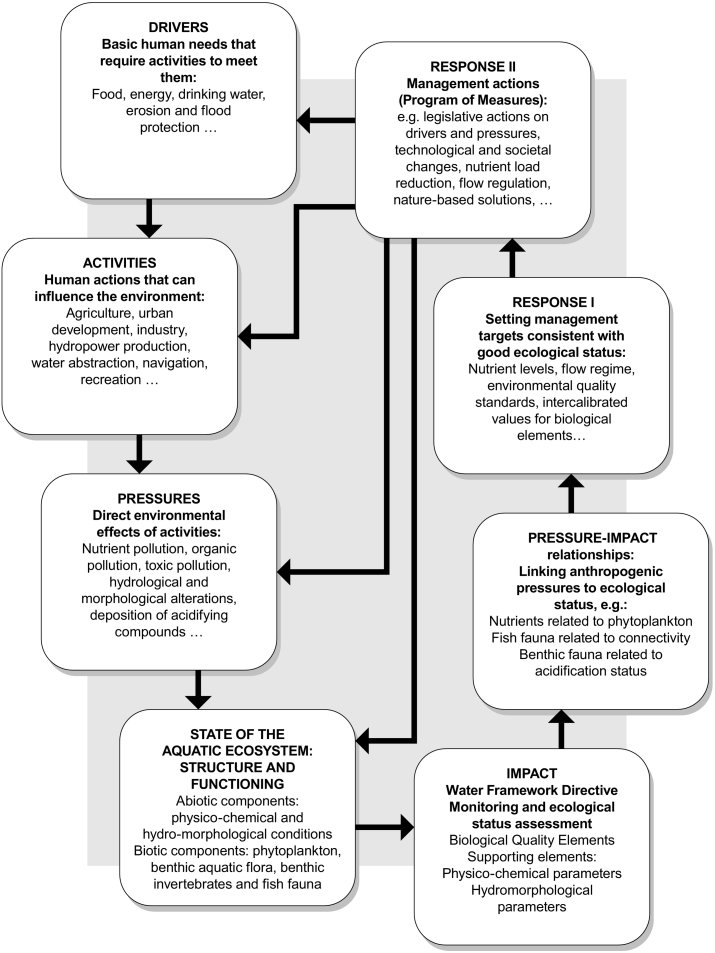
Conceptual scheme of the links between drivers, activities and pressures to ecosystem structure, functioning, and the related impacts assessment, under the Water Framework Directive (based on Solimini et al., 2009; Elliott et al., 2017; Anzaldua et al., 2018; EEA [European Environment Agency], 2018).